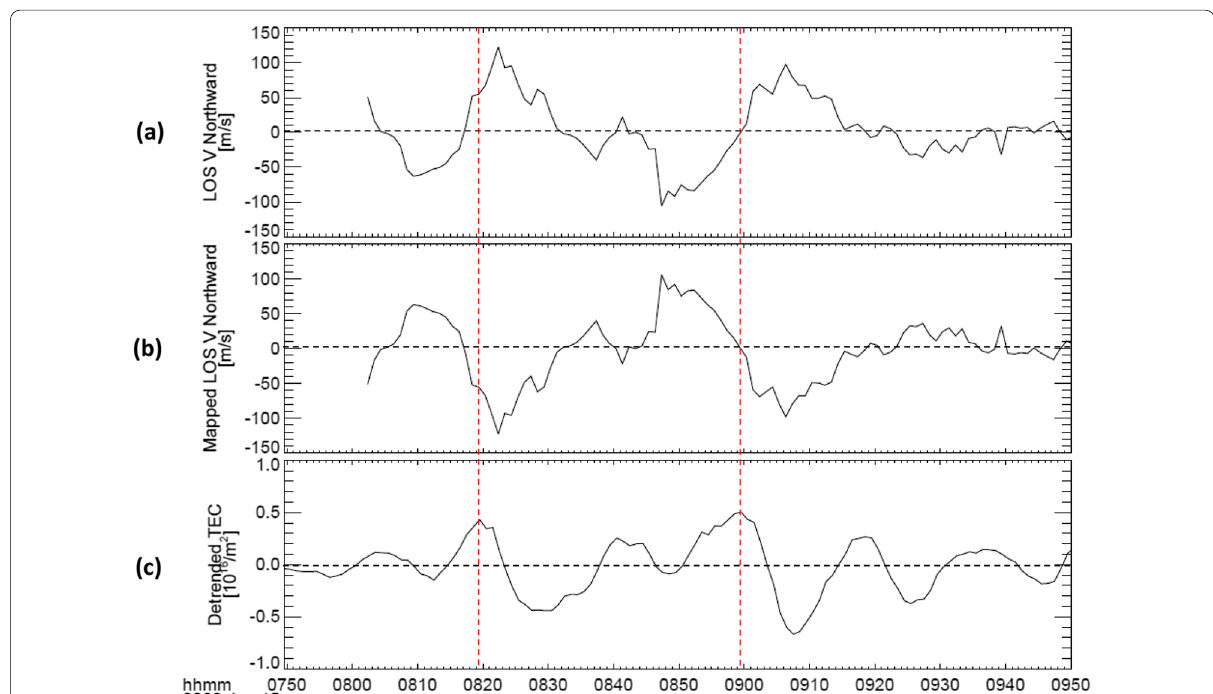
Fig. 5 Time-series plots of a line-of-site northward velocity, b line-of-site northward velocity mapped onto the Southern Hemisphere, and c detrended TEC with time interval from 07:50 to 09:50 UT on 15 January. These values are averaged within the number of range gate from 14 to 18. The two red dotted lines indicate the time of the peak values of two TEC variations with relatively large